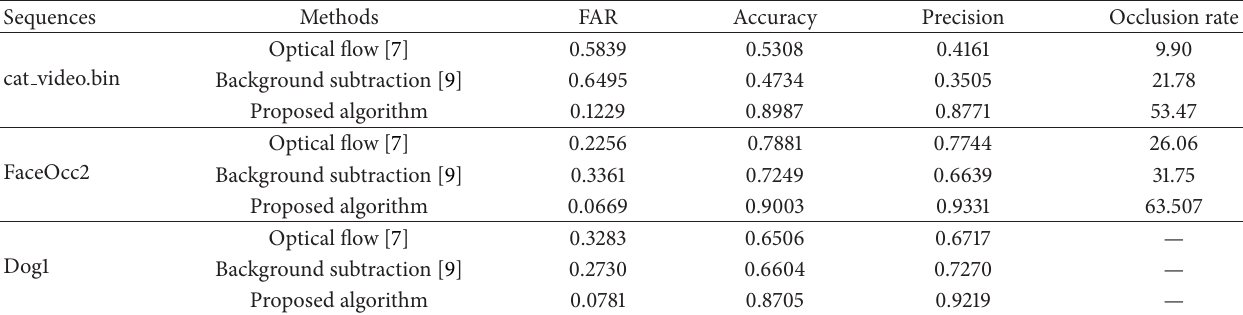
Table 3: Comparison of surveillance metrics on various